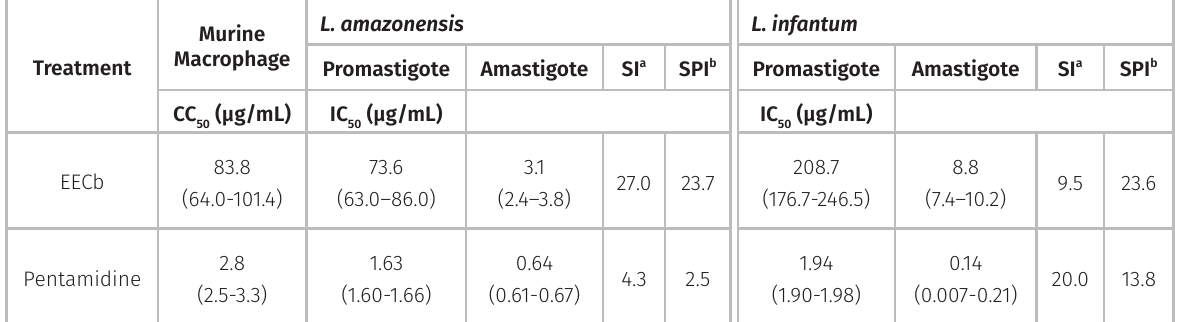
Table I. In vitro antileishmanial activity, cytotoxicity, specificity, and selectivity index for EECb.